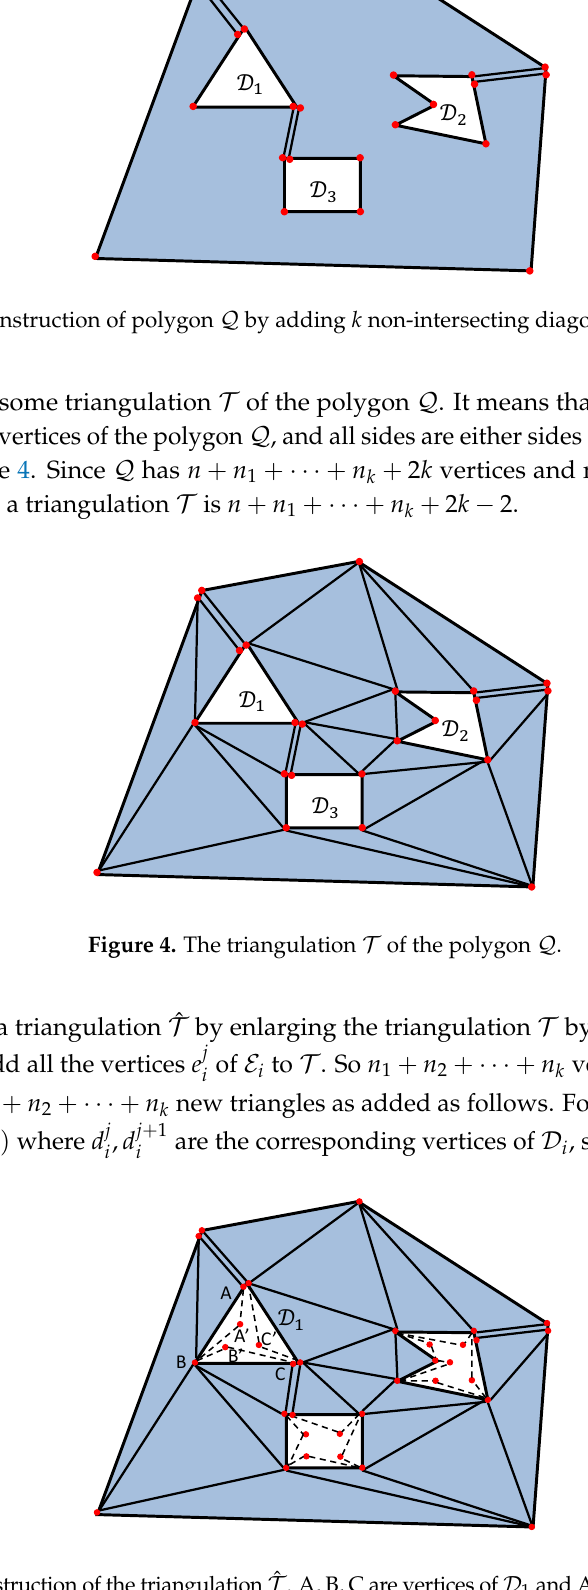
Figure 5. The construction of the triangulation ˆ T . A, B, C are vertices of D 1 and A’, B’, C’ are vertices of E 1